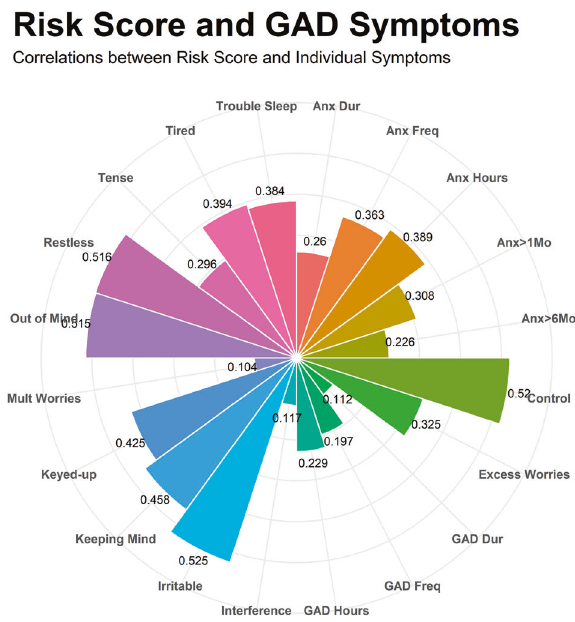
Fig. 5 Correlations between the Risk Score and Individual GAD Symptoms. This plot depicts the strength of correlations between the risk score and individual GAD